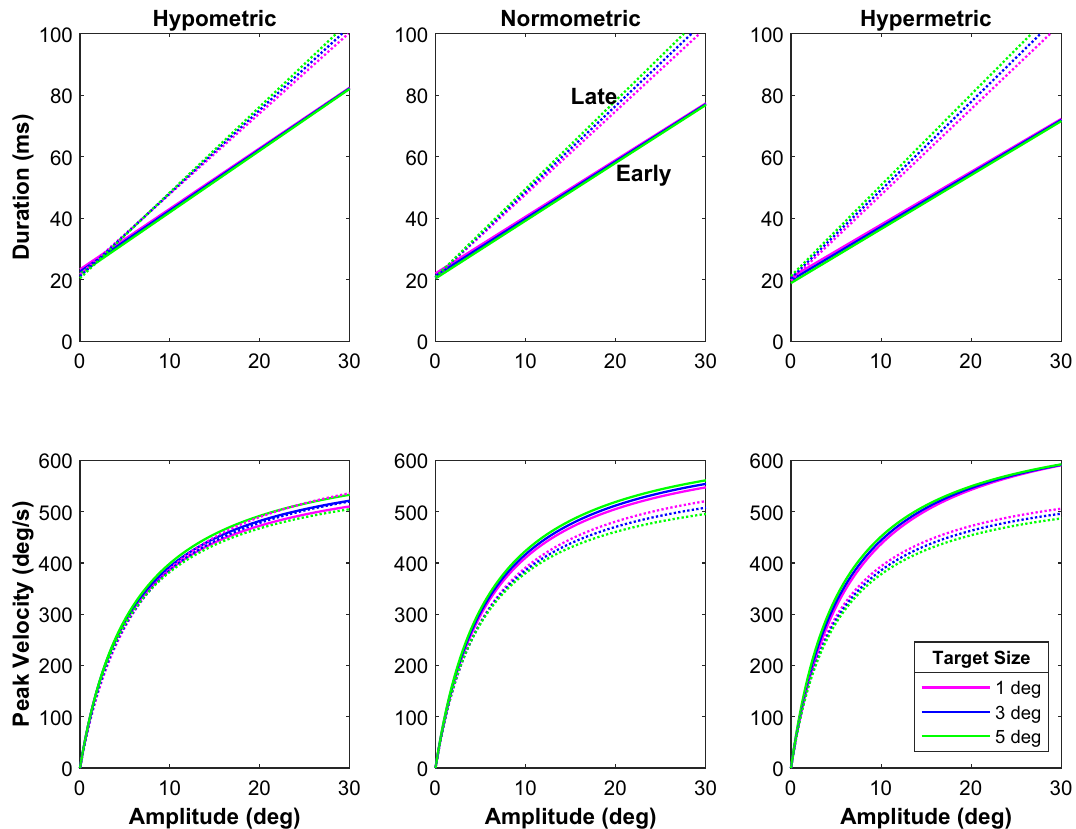
Figure 6. Effects of gain and latency on the main sequence. These plots show the relation between amplitude and duration and between amplitude and peak velocity that our respective regression models predict for different saccade gains, latencies and target sizes. Target size is color coded. The three columns are for different gains: hypometric (gain = 0.75), normometric (gain = 1.00), and hypermetric (gain = 1.25). The dotted lines represent the late saccades (latency 100 ms longer than the median latency) and the solid lines represent early saccades (latency 50 ms shorter than the median